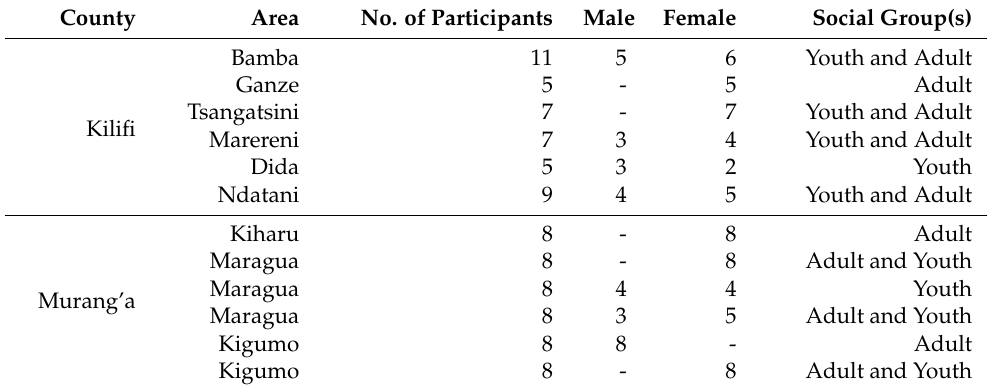
Table 1. Research